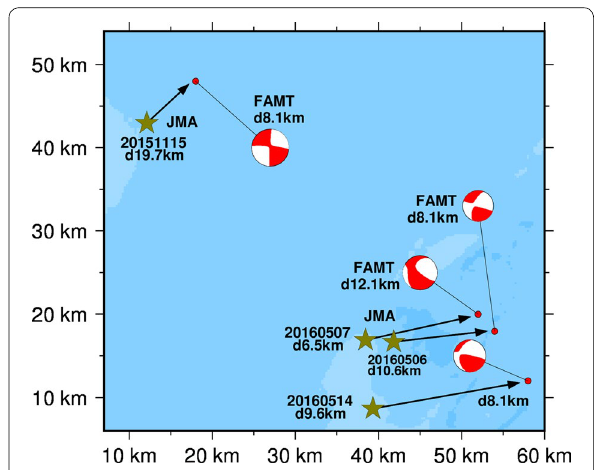
Fig. 7 Locations and depths of the FAMT solutions for EV2-5. Epicent- ers determined by JMA are also shown